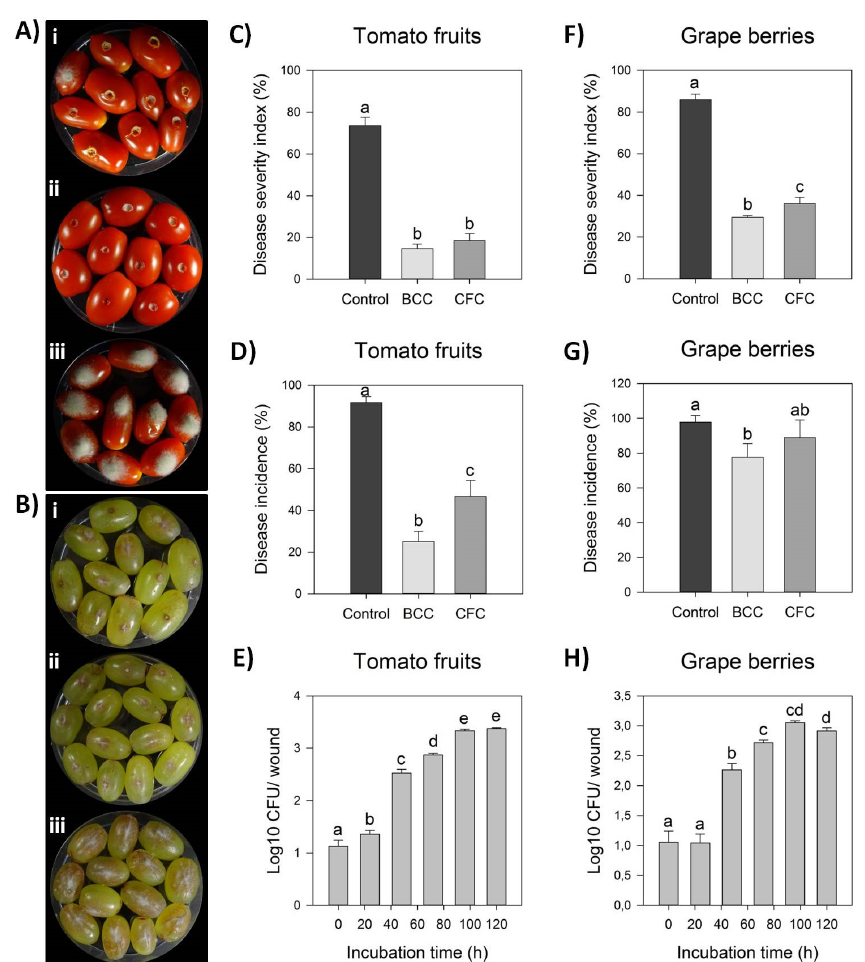
Figure 2. Antagonistic activity of endophytic bacterial strain Cal.l.30 against gray mold disease on tomato fruits and grape berries. ( A and B ) Suppression of gray mold disease after ex vivo formulation on grape berries and tomato fruits, respectively, after liquid bacterial cell culture (BCC) ( i ), liquid cell free culture (CFC) ( ii ) and individual formulation of B. cinerea as control treatment ( iii ). ( C and D ) Disease severity index (%) and Disease Incidence (%) on tomato fruits, respectively. ( E and F ) Disease severity index (%) and Disease incidence (%) on grape berries, respectively. Bars represent the mean ± SD of 3 independent biological replicates. Letters indicate the statistical differences between treatments at 4 days after inoculation (DAI) after Tukey analysis ( p < 0.05). ( G and H ) Time growth curve of Cal.l.30 (Log10 CFU/ wound) after inoculation in tomato fruit and grape berry wounds (one wound/ tomato or grape), respectively, without the presence of phytopathogenic fungus B. cinerea . Bars represent the mean ± SD of 4 independent biological replicates after Tukey analysis. Letters indicate the statistical difference per hour ( p < 0.05).